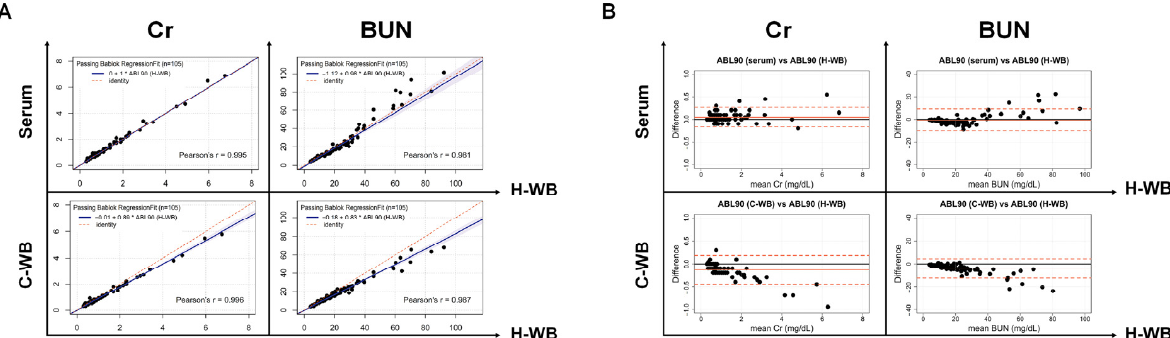
Figure 2. Passing–Bablok regression ( A ) and Bland–Altman plot ( B ) of Cr and BUN testing using the ABL90 FLEX PLUS comparing the primary specimen (H-WB) and candidate specimens (serum and C-WB). ( A ) The blue-colored area represents the 95% CI of the regression line. ( B ) The black and orange solid lines indicate the zero and mean differences, respectively. The dashed orange line represents the two SDs of the mean difference. Cr: creatinine; BUN: blood urea nitrogen; H-WB: heparinized whole blood; C-WB: sodium-citrated whole